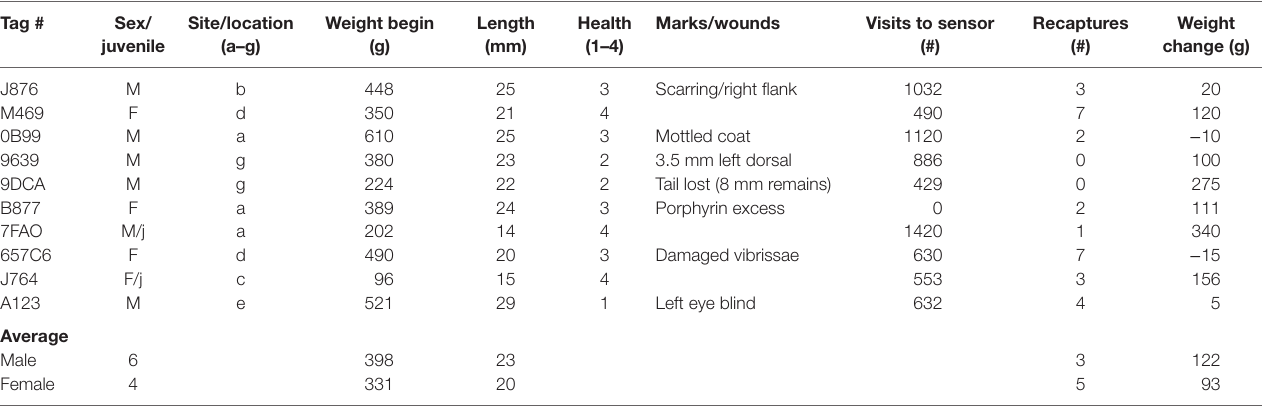
tABlE 1 | representative physical characterization. tag #